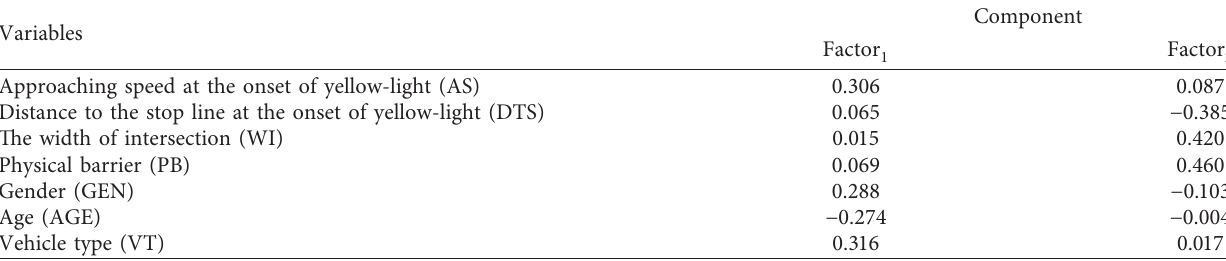
Table 6: Matrix of component